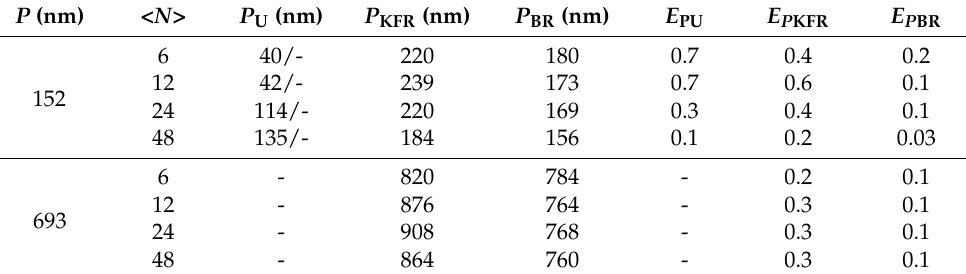
Table 5. Performance indices for the recovery of 152 and 693 nm PSDs.